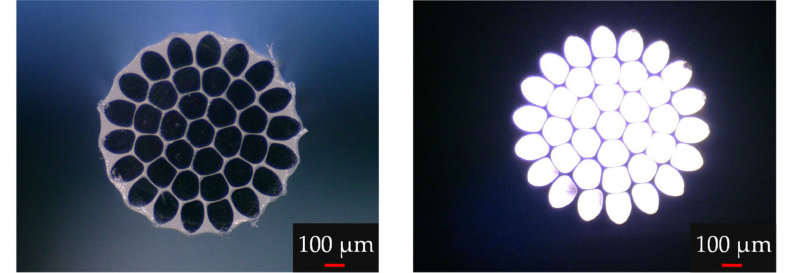
Figure 3. Microscopy image of the cross section of the VB-1000, reproduced with permission from Asahi Kasei Corporation, Tokyo,